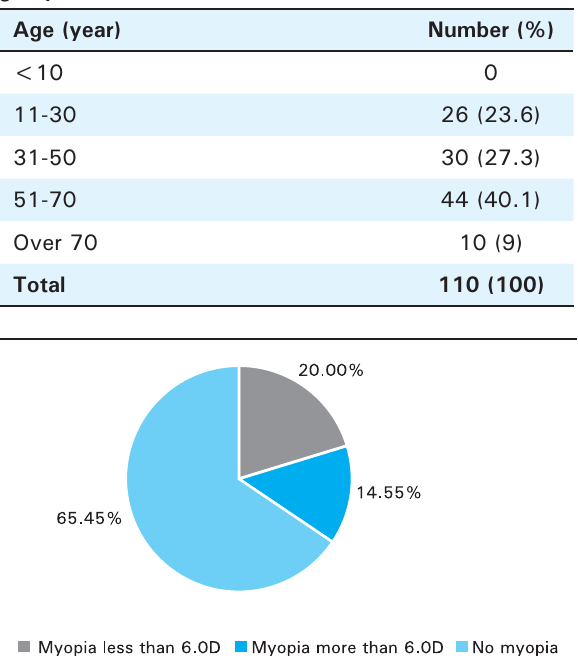
Table 1. Distribution of patients according to age